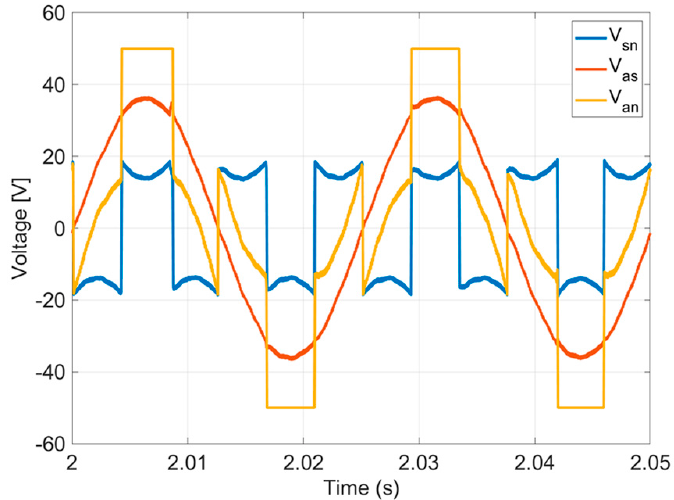
Figure 8. Voltage relations of 60 ° DPWM.